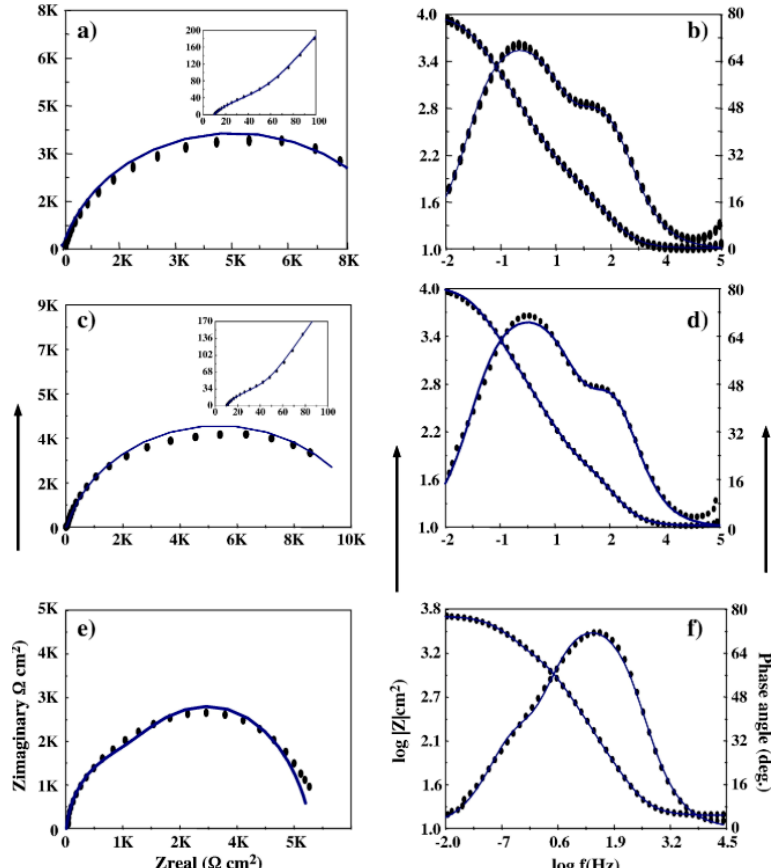
Figure 6. Nyquist and Bode plots for pulse deposited cobalt–phosphorous (Co–P) coating on mild steel substrate: ( a , b ) Co–P (7 wt.% P); ( c , d ) Co–P (9 wt.% P); and ( e , f ) Co–P (12 wt.% P) [49].